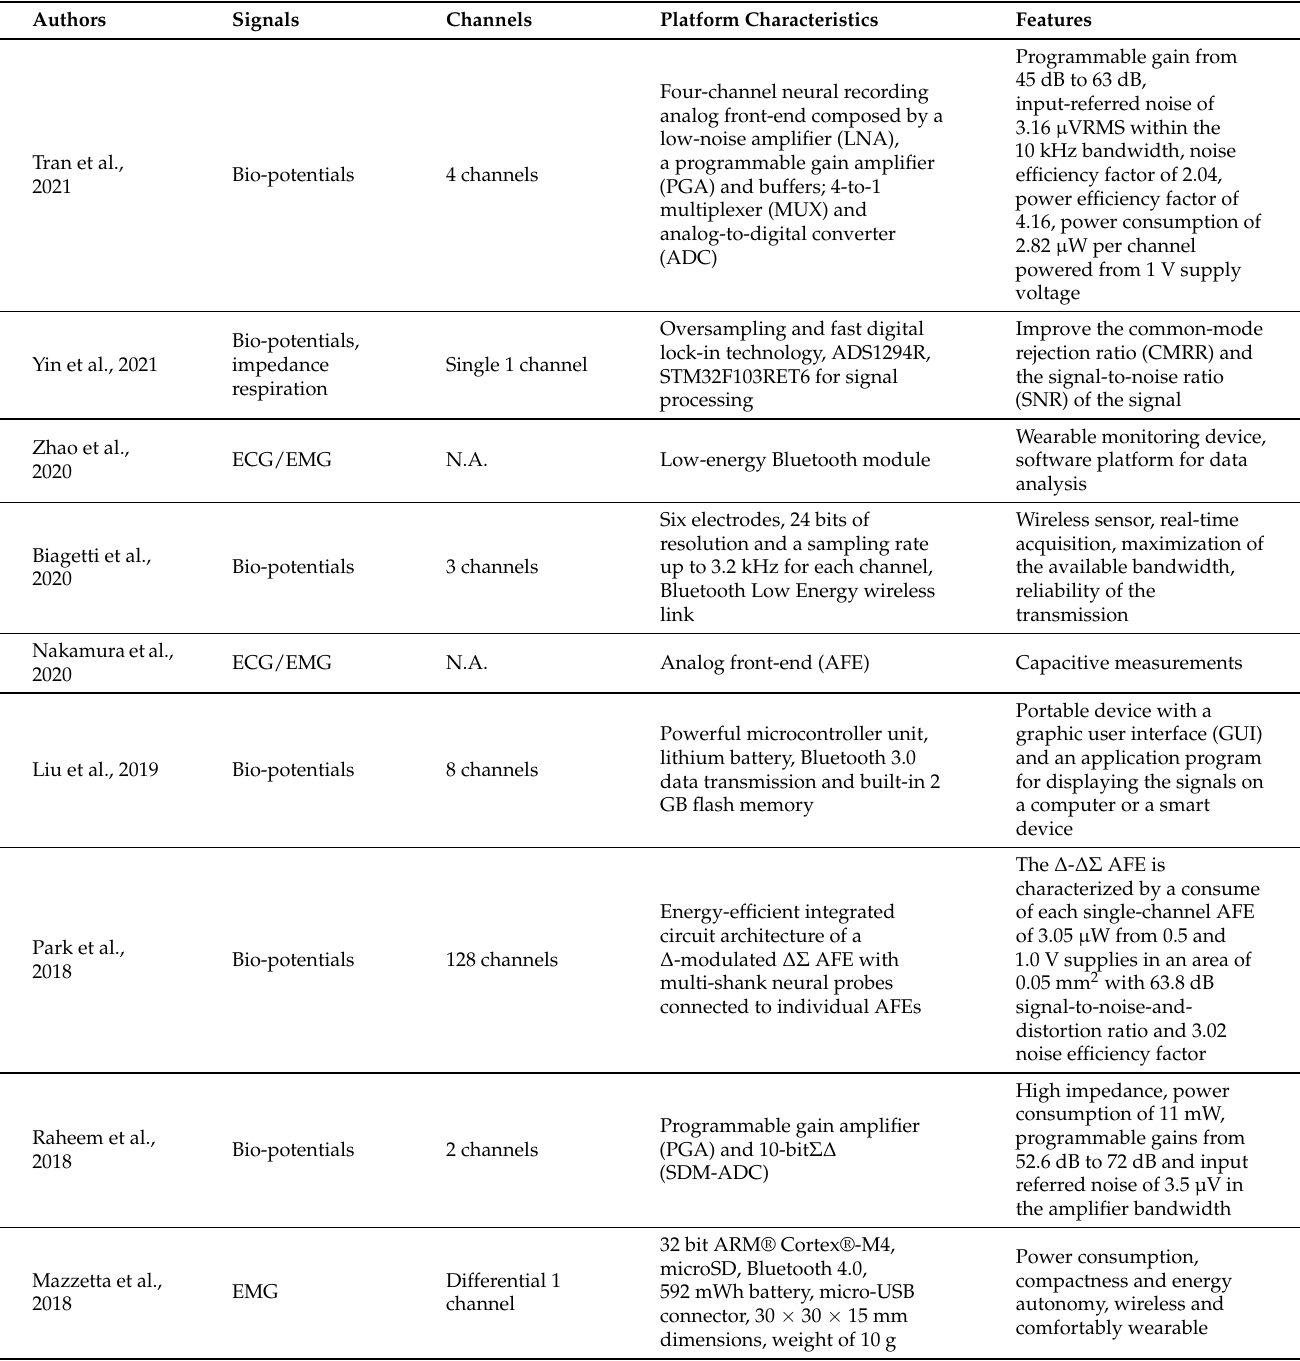
Table 2. Summary of selected wearable monitoring system included in this